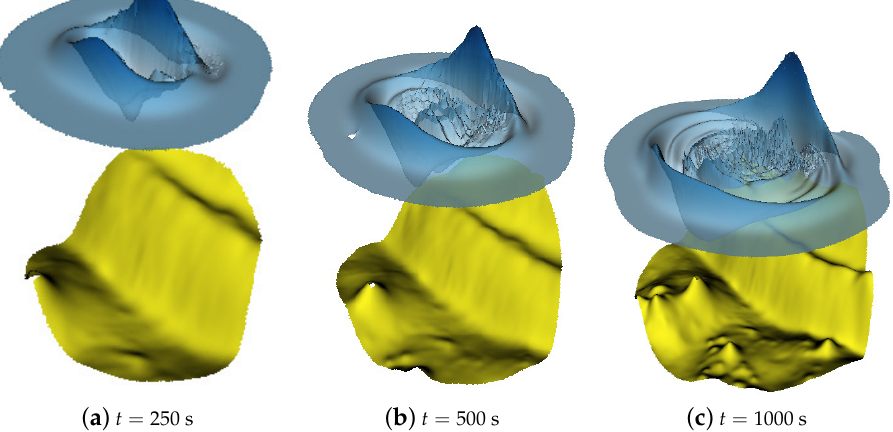
Figure 14. Passive generation: the bottom together with the free surface elevation at different instances of time obtained with the proposed domain adaptivity method.